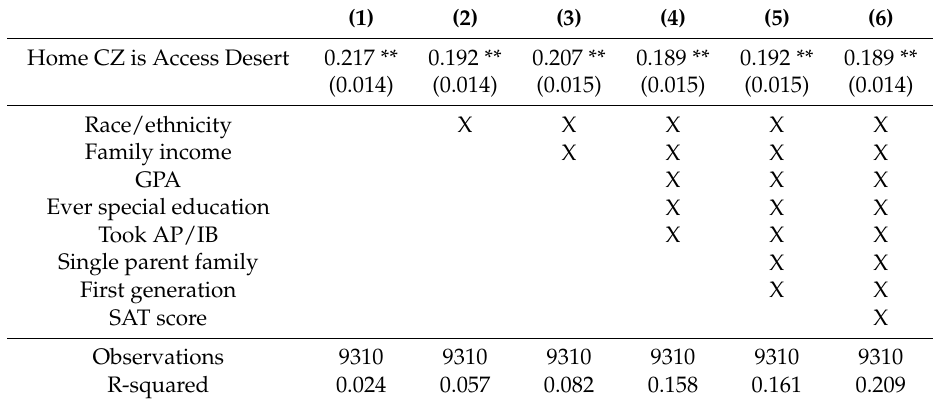
Table 3. Relationship between living in an access desert and applying to a college outside of home commuting zone.